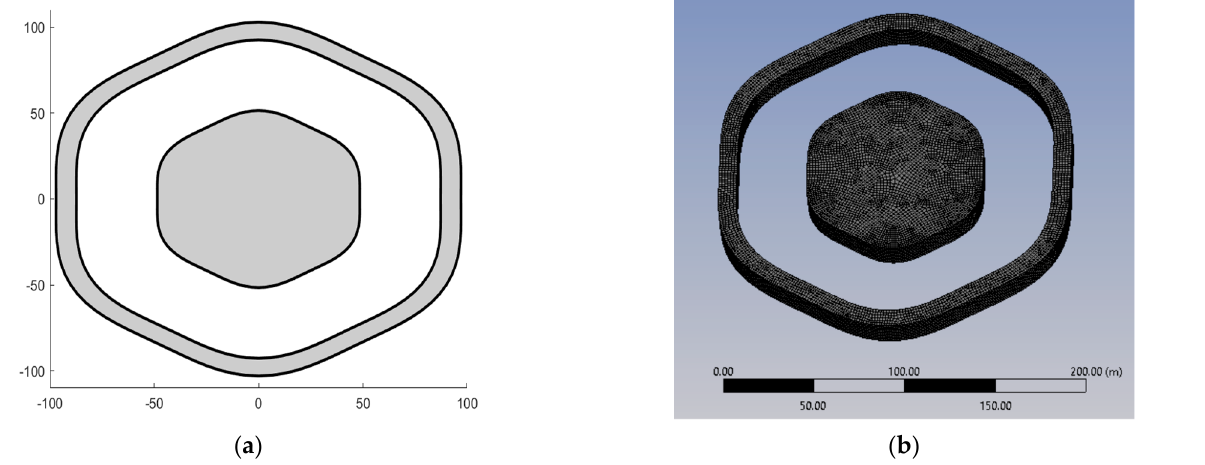
Figure 3. Hexagonal ring structure for verification study: ( a ) plan view; ( b ) 3D mesh model (AQWA).